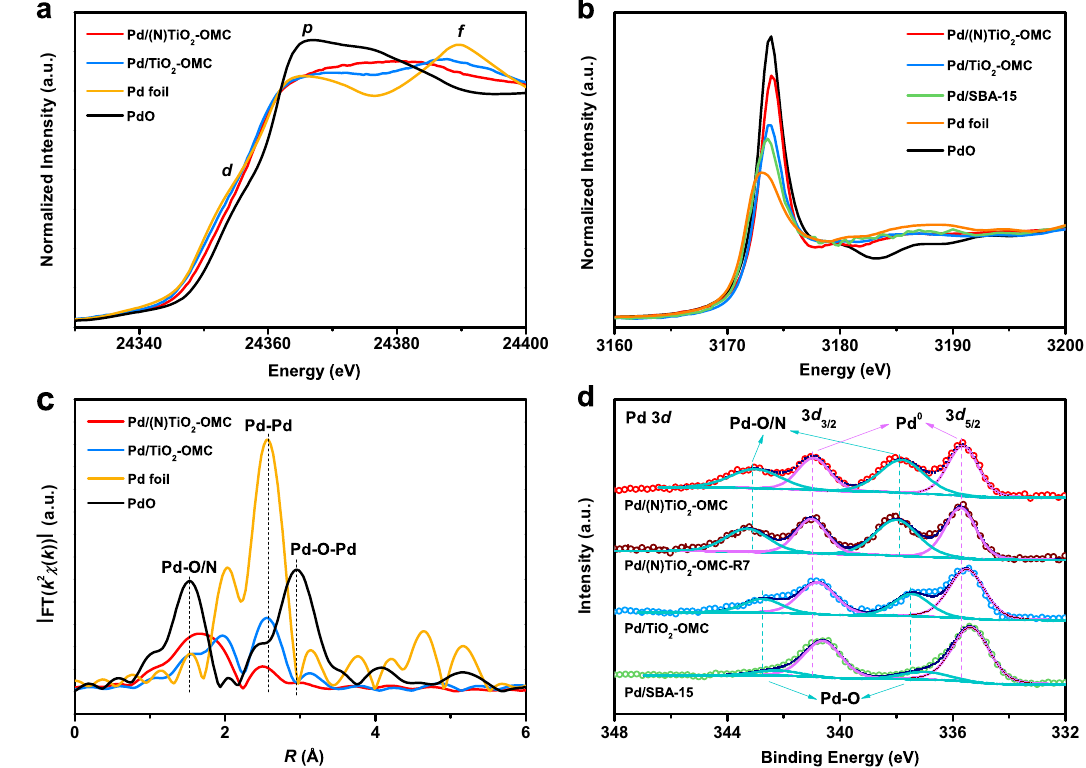
Fig. 2 Electronic properties. a , b XANES spectra of the a Pd K -edge and b Pd L 3 -edge, c k 2 -weighted and FT-EXAFS spectra of the Pd K -edge, and d XPS spectra of the 3 d level of Pd for Pd/TiO 2 -OMC and Pd/(N)TiO 2 -OMC catalysts. The reference samples include a Pd foil, PdO, and Pd/SBA-15. The Fourier transforms in c were not corrected for phase shifts. The Pd binding energies in d were fi tted by peak fi tting programs. Pd/(N)TiO 2 -OMC-R7 is the catalyst after being used in seven